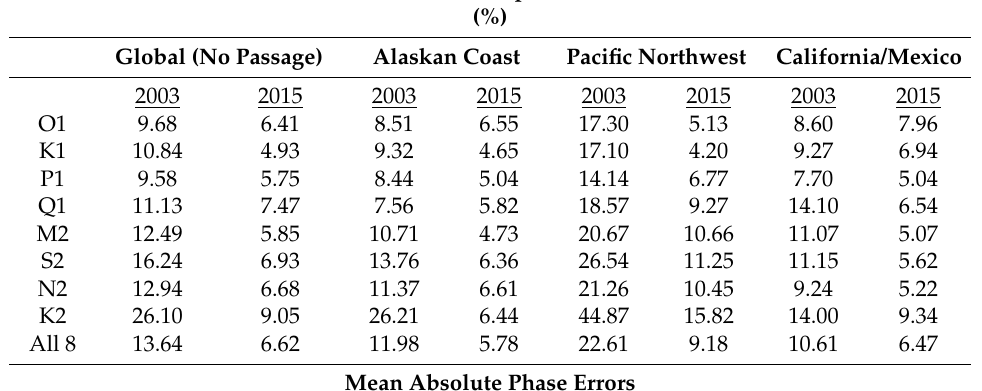
Table 7. Comparison of mean relative amplitude (%) and mean absolute phase errors (deg) by region for each of the eight primary harmonic constituents and summed over all 8 constituents for the ENPAC03 (2003) and ENPAC15 (2015) tidal databases: only the 179 wet validation stations are used in the